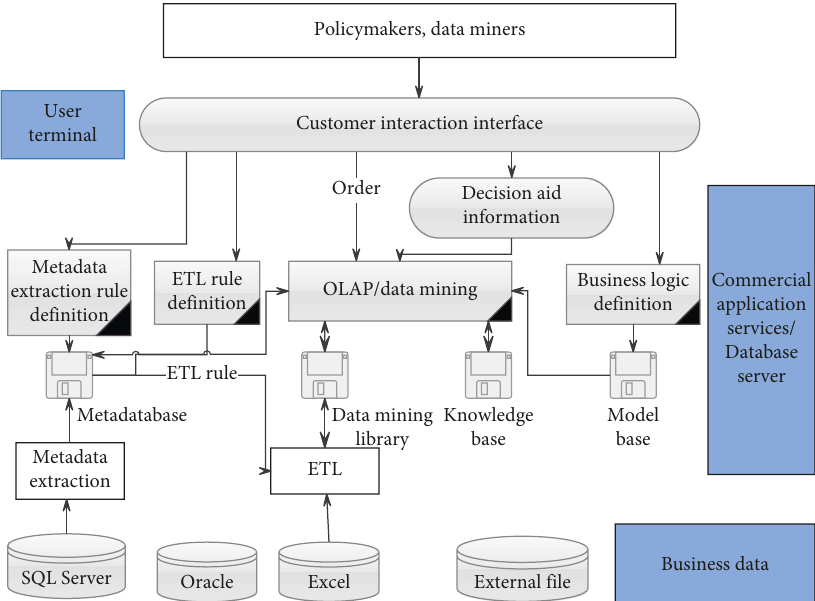
Figure 8: Schematic diagram of the logical structure of the platform.